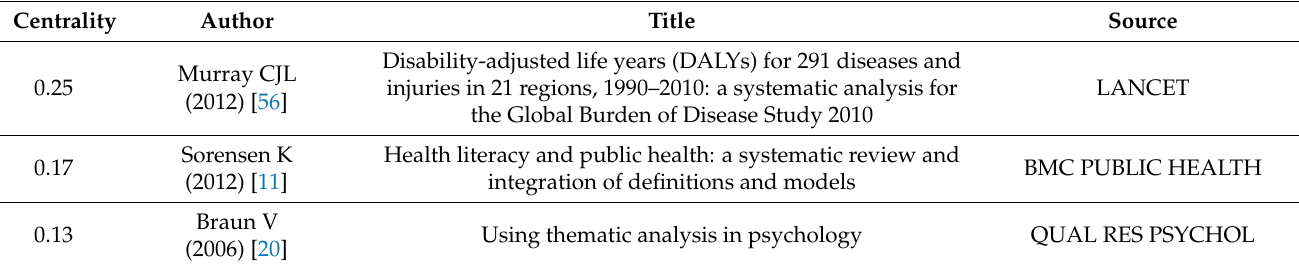
Table 5. The top three articles in terms of